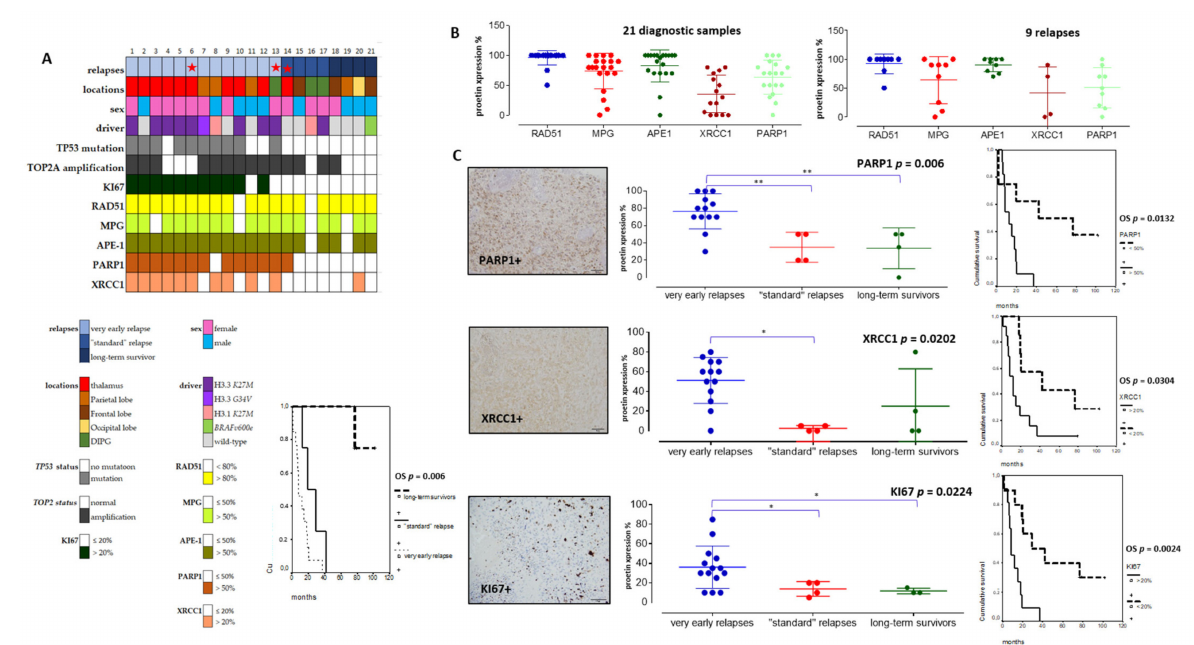
Figure 4. Immunohistochemical analyses in a tissue-microarray collection of 21 pHGGs and their significant correlations with relapses and overall survival (OS). ( A ) Heatmap of clinical, molecular, and protein expressions in the 21 pHGGs associated to a Kaplan Meier analysis of the overall survival discriminating the different subgroups (based on relapsing time). ( B ) Analyses of RAD51, MPG, APE1, XRCC1, and PARP1 protein expressions in 21 pHGG diagnostic samples and 9 paired relapses. ( C ) Comparative analyses of PARP1, XRCC1, and KI67 expressions within each treatment response group, together with an example of their histological immunostaining and Kaplan Meier analyses illustrating their significant impact on overall survival (OS). * and ** signs are underlining statistical significances with a p below 0.05.